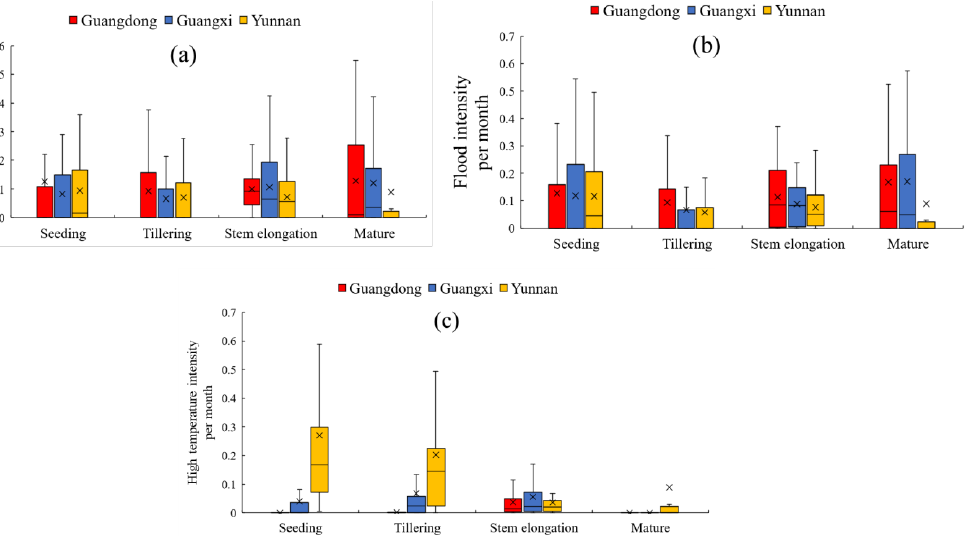
Figure 8. The monthly intensities of drought ( a ), flood ( b ), and HT ( c ) during different sugarcane growth stages in southern China. × and — in the boxes represent the mean and median values, respectively.